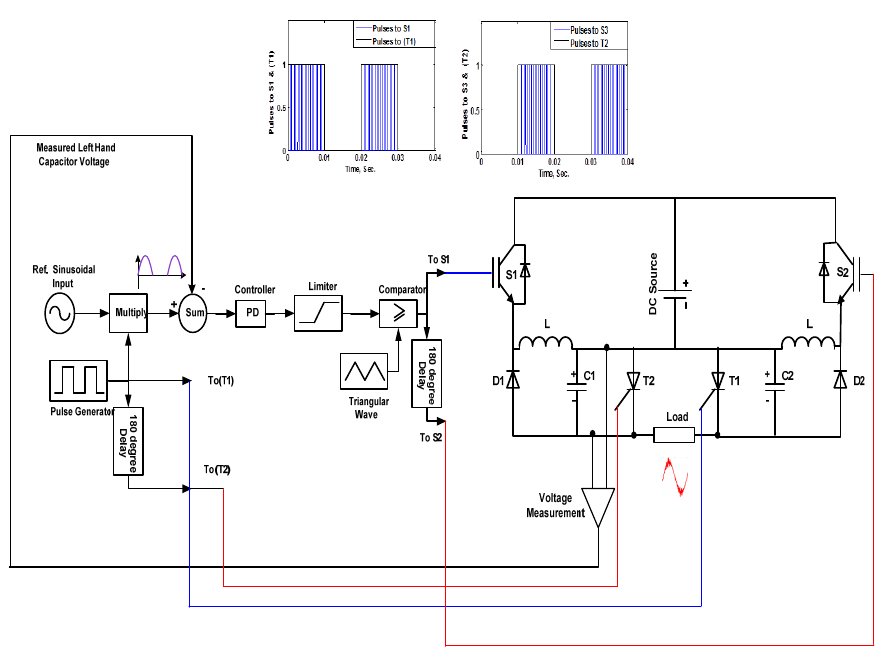
Figure 6. The Adopted Control Technique of the DC–AC Buck–Boost Converter.